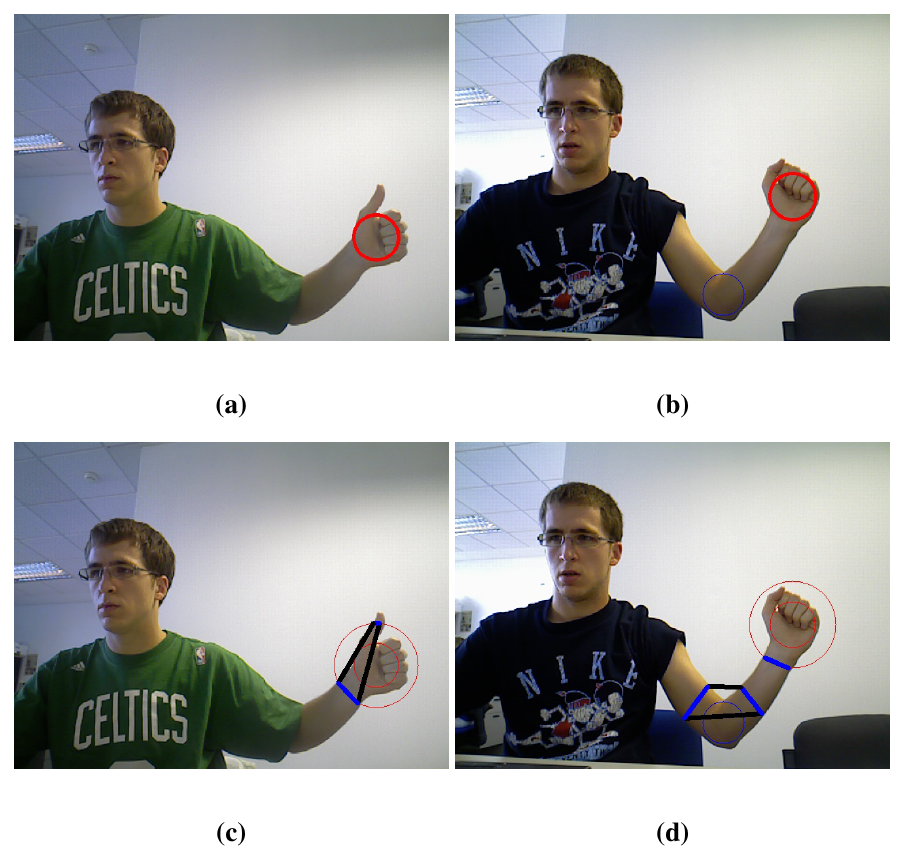
Figure 3. Skin region classification: ( a ) Palm circle when the elbow is not shown; ( b ) Palm and elbow circles; ( c ) Skin segments (blue lines) of the hand; ( d ) Skin segments (blue lines) of hand and